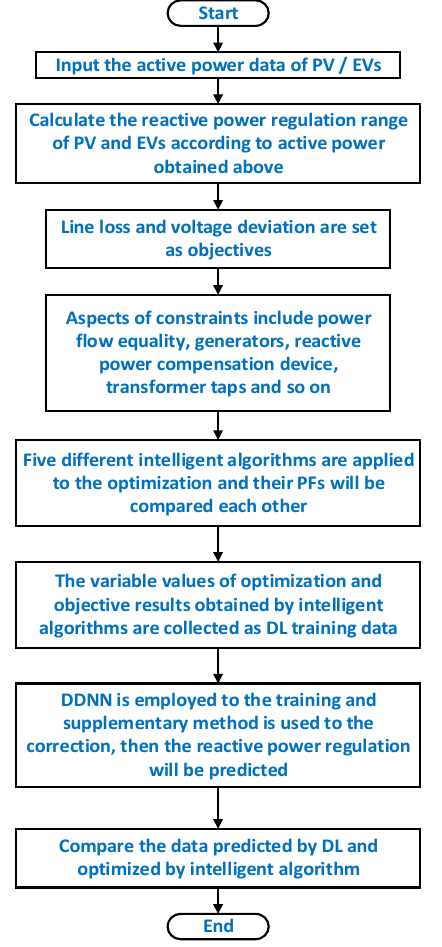
Figure 3. Flow chart of prediction with DL.